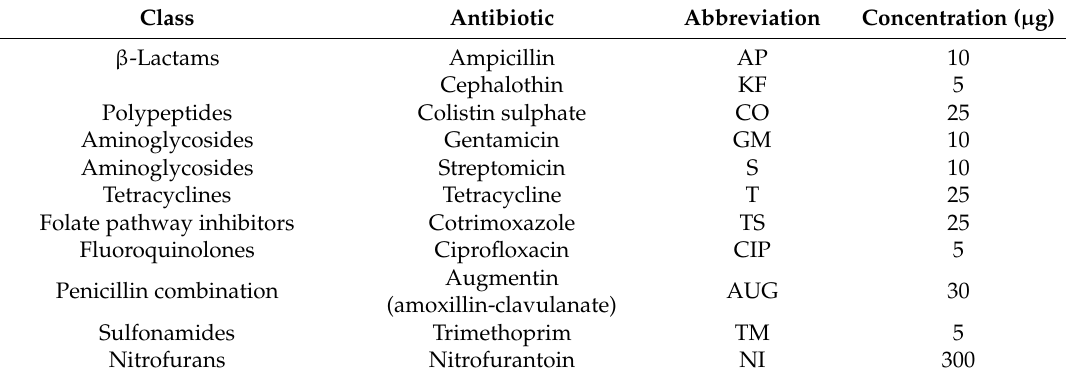
Table 1. Antibiotics used to determine antibiotic resistance of E. coli